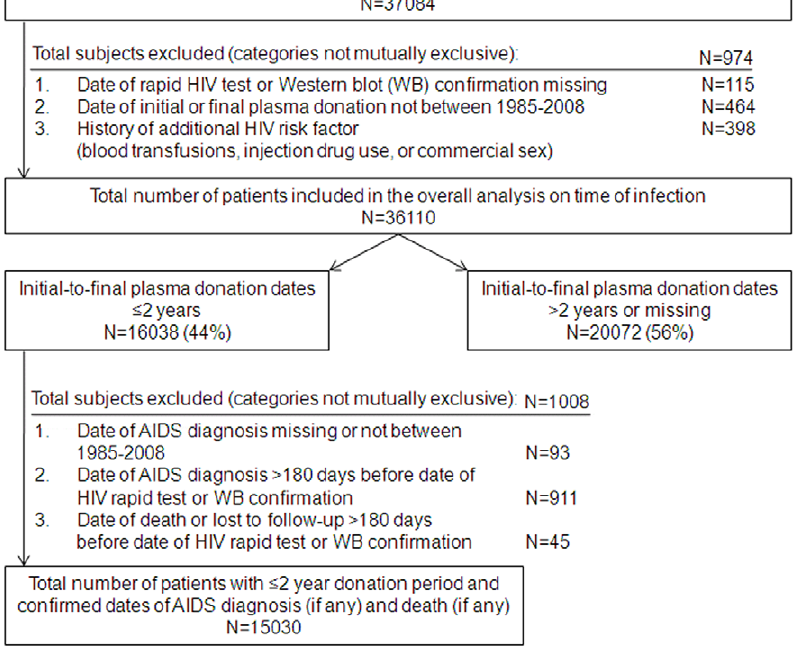
Figure 1. Selection criteria for HIV-infected former plasma donors (FPD) included in the analysis. Selection criteria for the 36110 HIV- infected former plasma donors (FPD) included in the overall analysis, the 16038 FPDs included in the estimation of the date of HIV infection, and the 15030 FPDs included in the survival analysis.